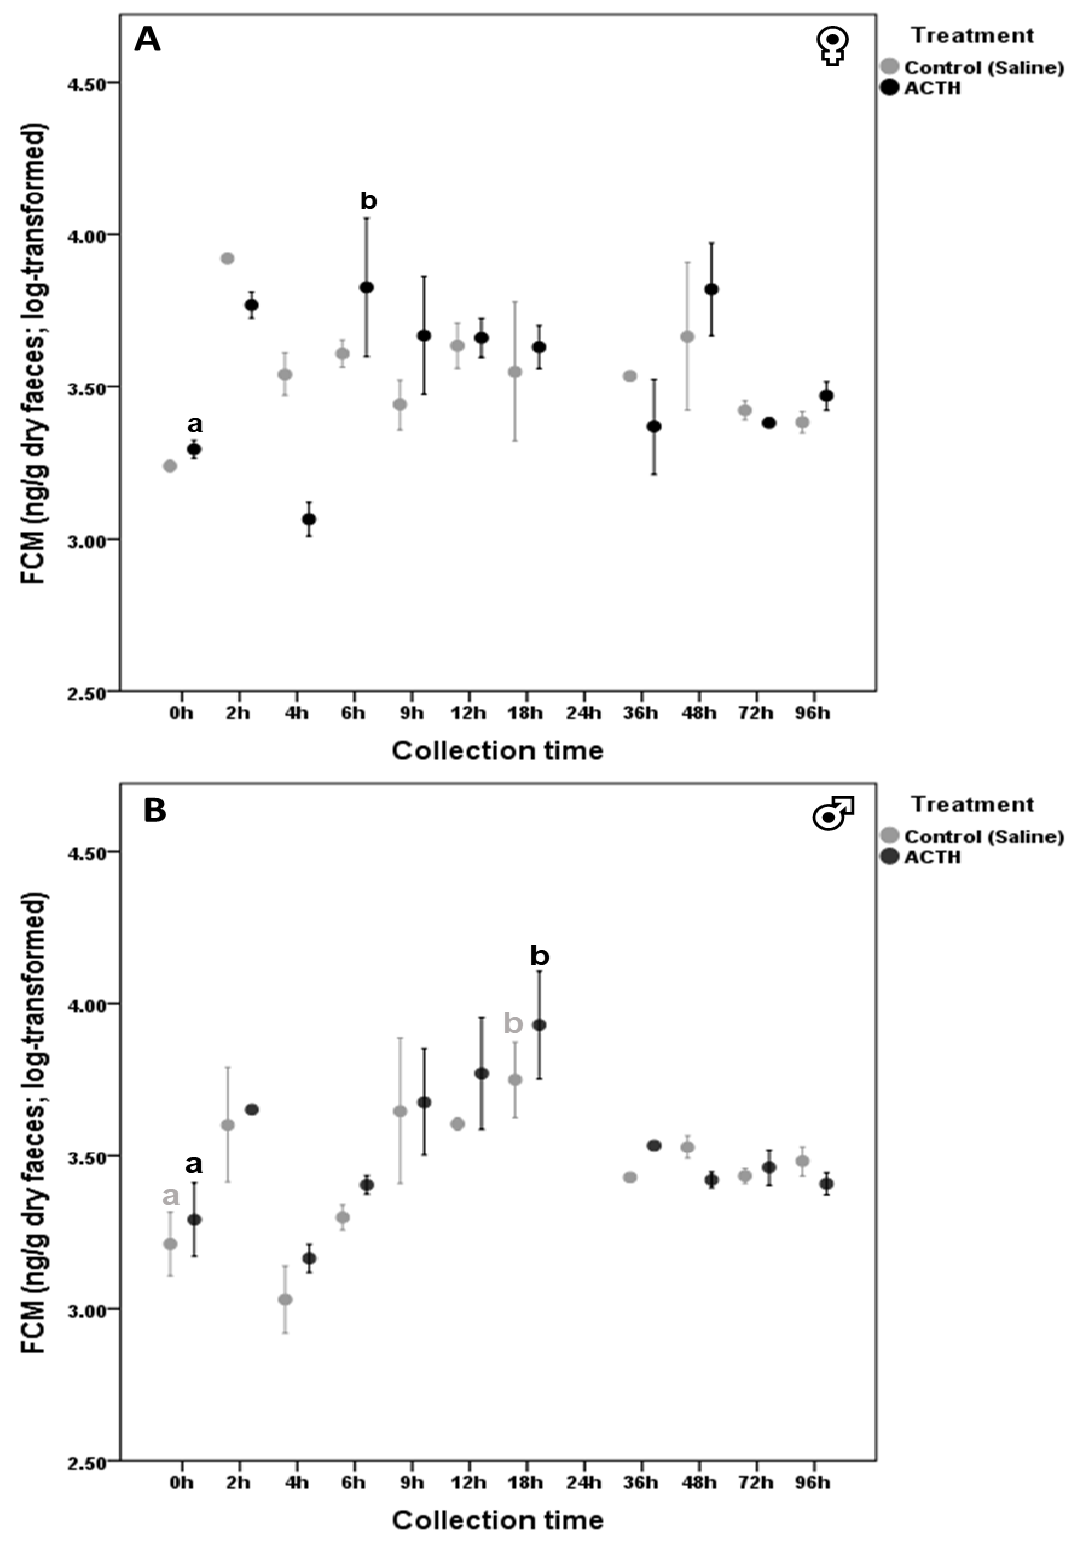
Figure 1. Fecal Corticosterone Metabolite variation (mean ± SE) in G. andersoni females ( A ) and males ( B ) after ACTH (adrenocorticotropic hormone)/saline solution injection ( n = 3 per experimental group). Significant differences between basal (values at 0 h, i.e., right before the injection) and peak FCM (fecal corticosterone metabolites) values are indicated with different small letters. G. gerbillus (males) experienced increased FCM levels after the ACTH (LMM: F 1,11 = 4.248, p = 0.002), showing significant FCM peak concentrations at 6 h ( β = 0.653, SE = 0.140, 95% CI = 0.224, 1.081, p = 0.016) and 24 h ( β = 0.731, SE = 0.066, 95% CI = 0.553, 0.910, p < 0.001) following administration (Figure 2). In this species, the control group also mounted increased FCM levels (LMM: F 1,11 = 4.248, p < 0.001) reaching a significant maximal value 48 h after the saline solution injection ( β = 0.850, SE = 0.082, 95% CI = 0.600, 1.099, p = 0.001; Figure 2).